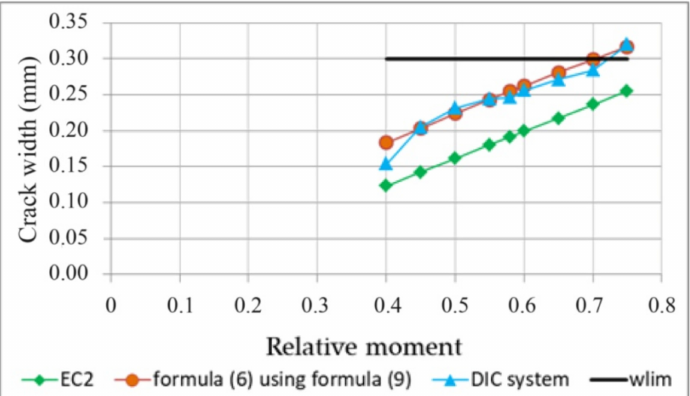
Figure 34. Crack widths at selected levels of critical stress–strain